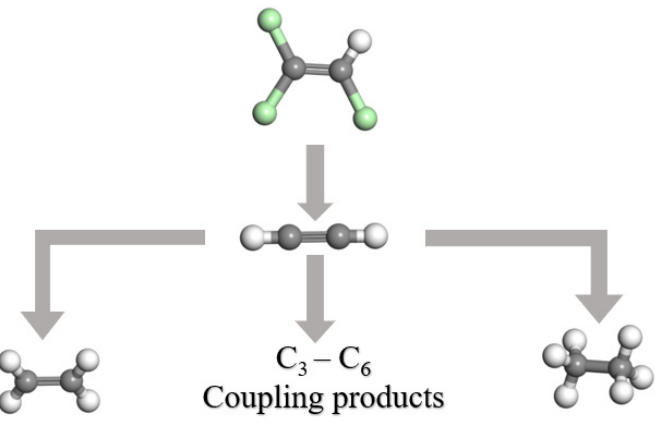
Figure 7. A possible mechanism for the TCE degradation with the S-nZVI.